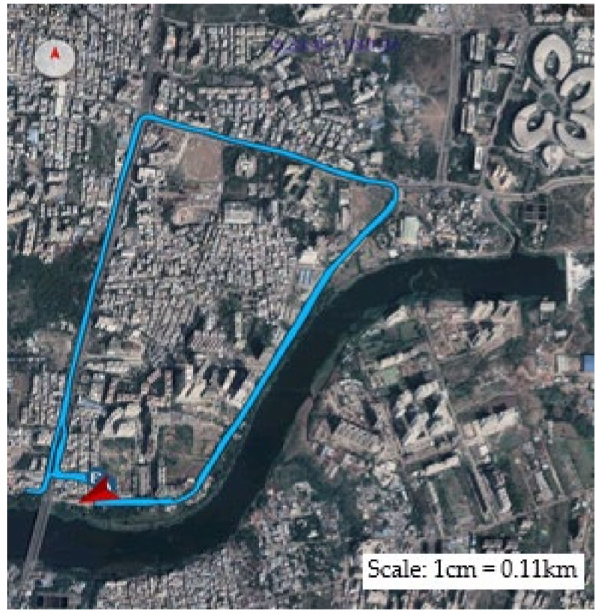
Figure 11. Selected route map for drive